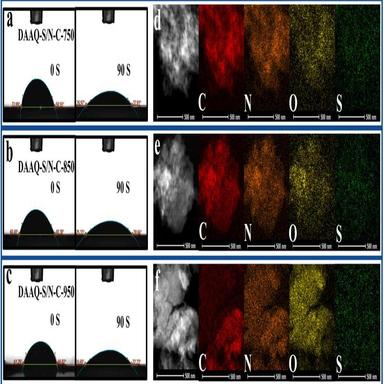
a-c) Water droplet contact angle after 0 s and 90 s images of DAAQ-S/N-C-750, DAAQ-S/N-C-850, and DAAQ-S/N-C-950 electrode materials. d-f) Elemental mapping images of C, N, O, and S in the DAAQ-S/N-C-750, DAAQ-S/N-C-850, and DAAQ-S/N-C-950 electrode materials, respectively.